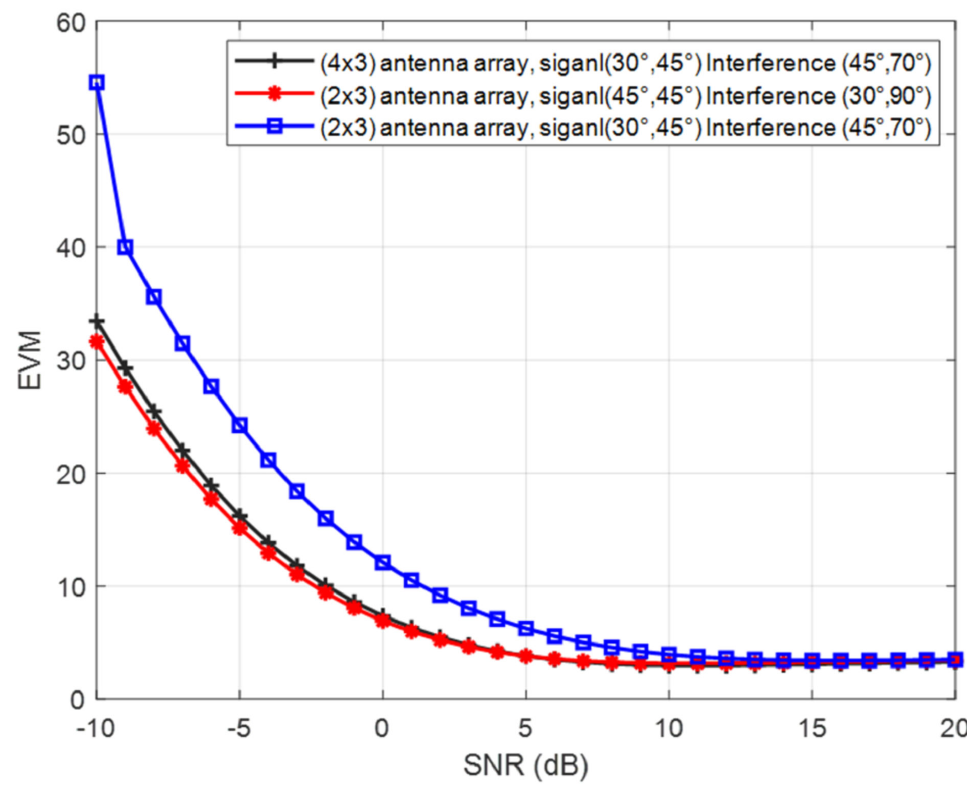
Figure 29. EVM versus SNR over AWGN channels. Table 2. The performance for the three